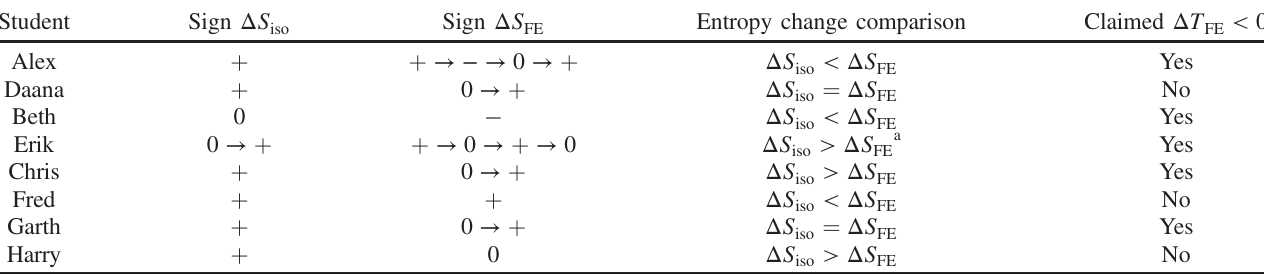
is the change in temperature of the gas undergoing the free expansion. A “ yes ” in this FE